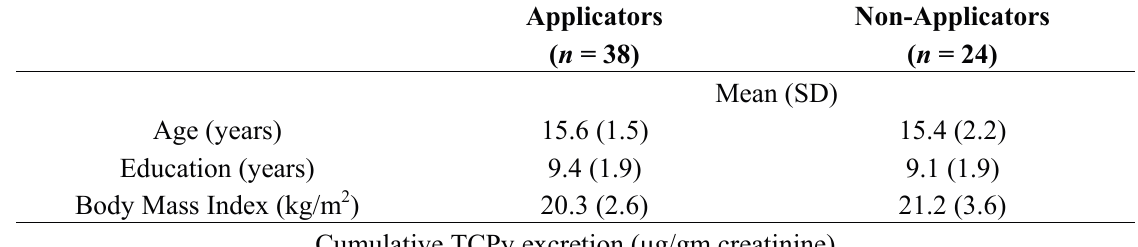
Table 1. Selected characteristics of EGAD study participants by applicator